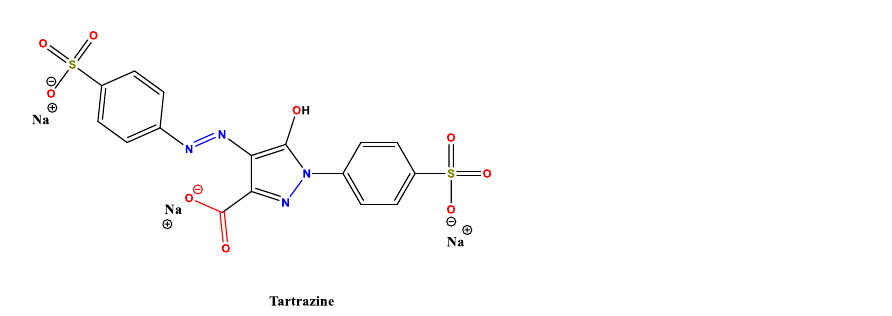
Figure 6. Tartrazine chemical structure. Adapted from Reference [48]. Copyright 2007, Elsevier.